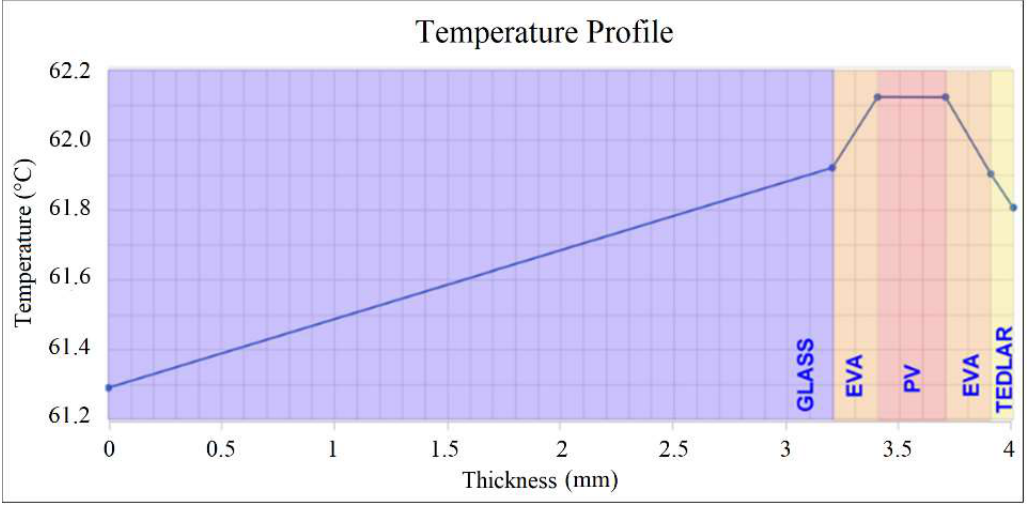
Figure 11. Temperature of the panel at noon of July